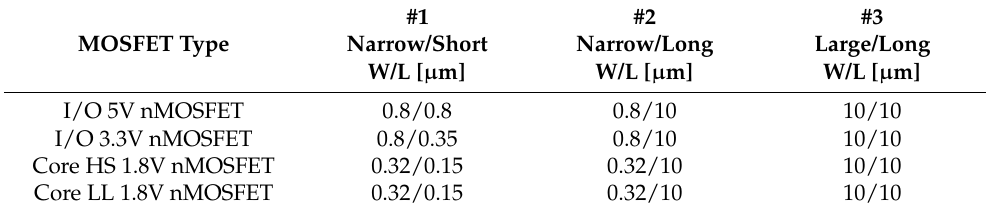
Table 1. Device types and dimensions 1